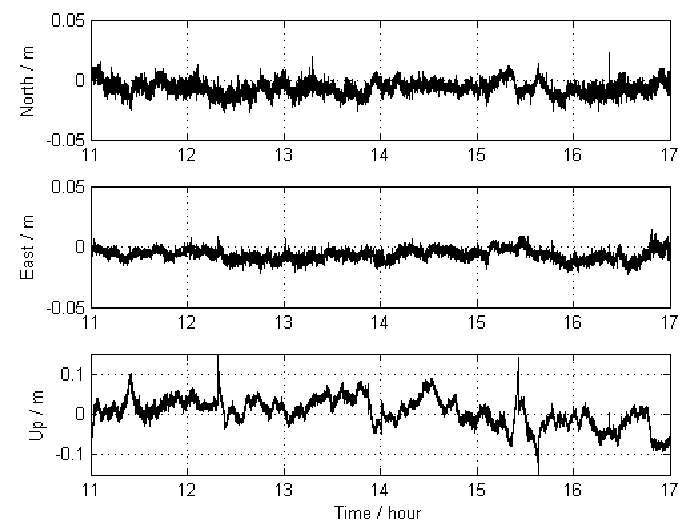
Figure 6. Differences between the trajectories of KIN1 for the scenario with far-away-located reference